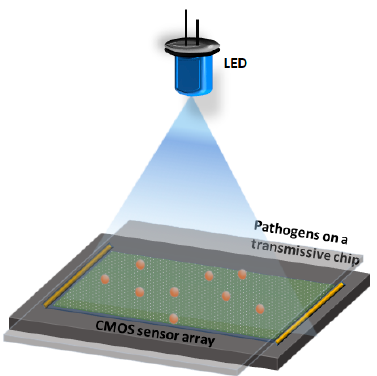
Figure 6. Schematic of a lensless digital holographic imaging system. A simple imaging system consists of a light source, complementary metal-oxide semiconductor (CMOS) sensor array, and a / substrate containing the semi-transparent chip/substrate containing the sample. semi-transparent chip